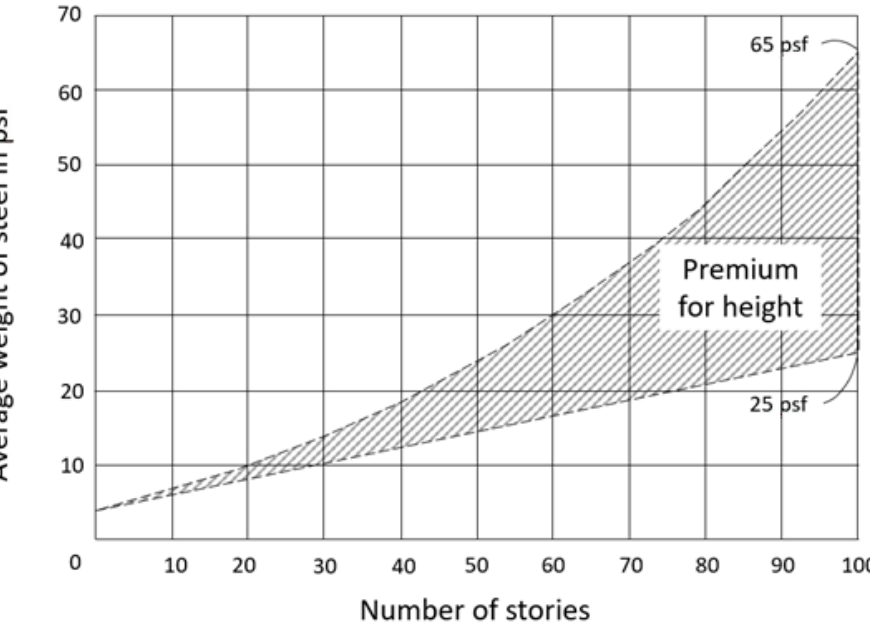
Figure 1. “Premium for height” by Fazlur R. Khan. (Source: [5], p. 41).